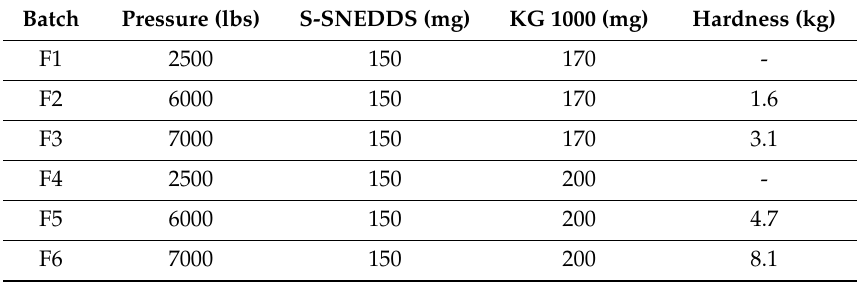
Table 1. E ff ect of pressure and amount of diluent on the hardness of vaginal